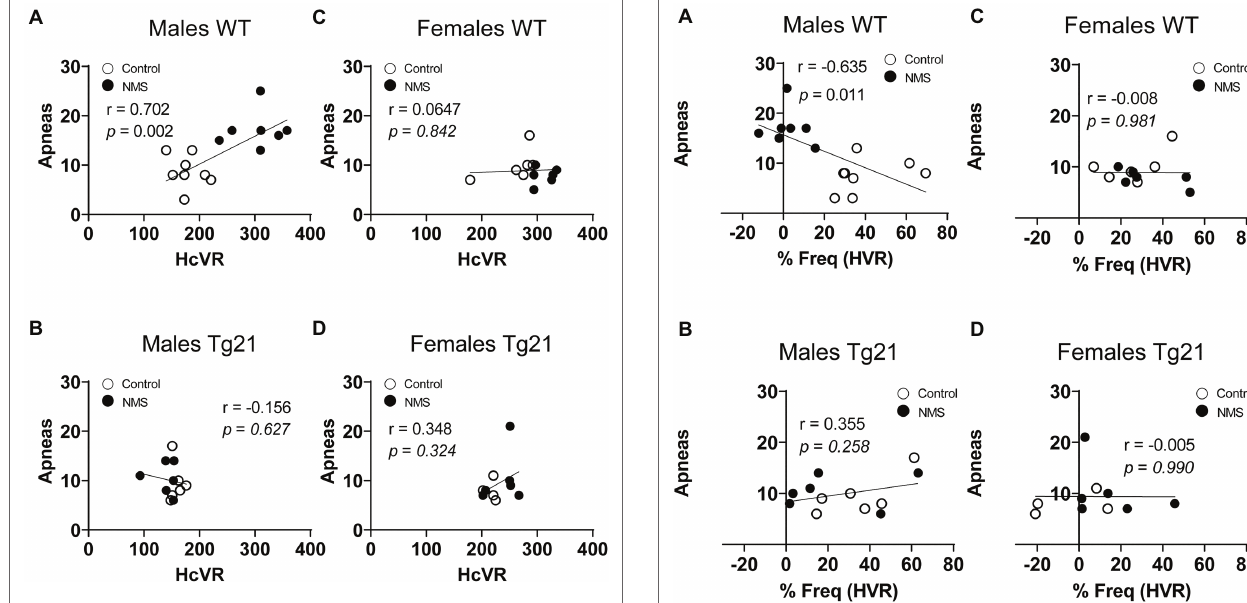
FIGURE 7 | Correlation between apneic events and percentage of change in respiratory frequency (in HVR) in WT and Tg21 male (A,B) and female (C,D) mice previously exposed (or not – control) to